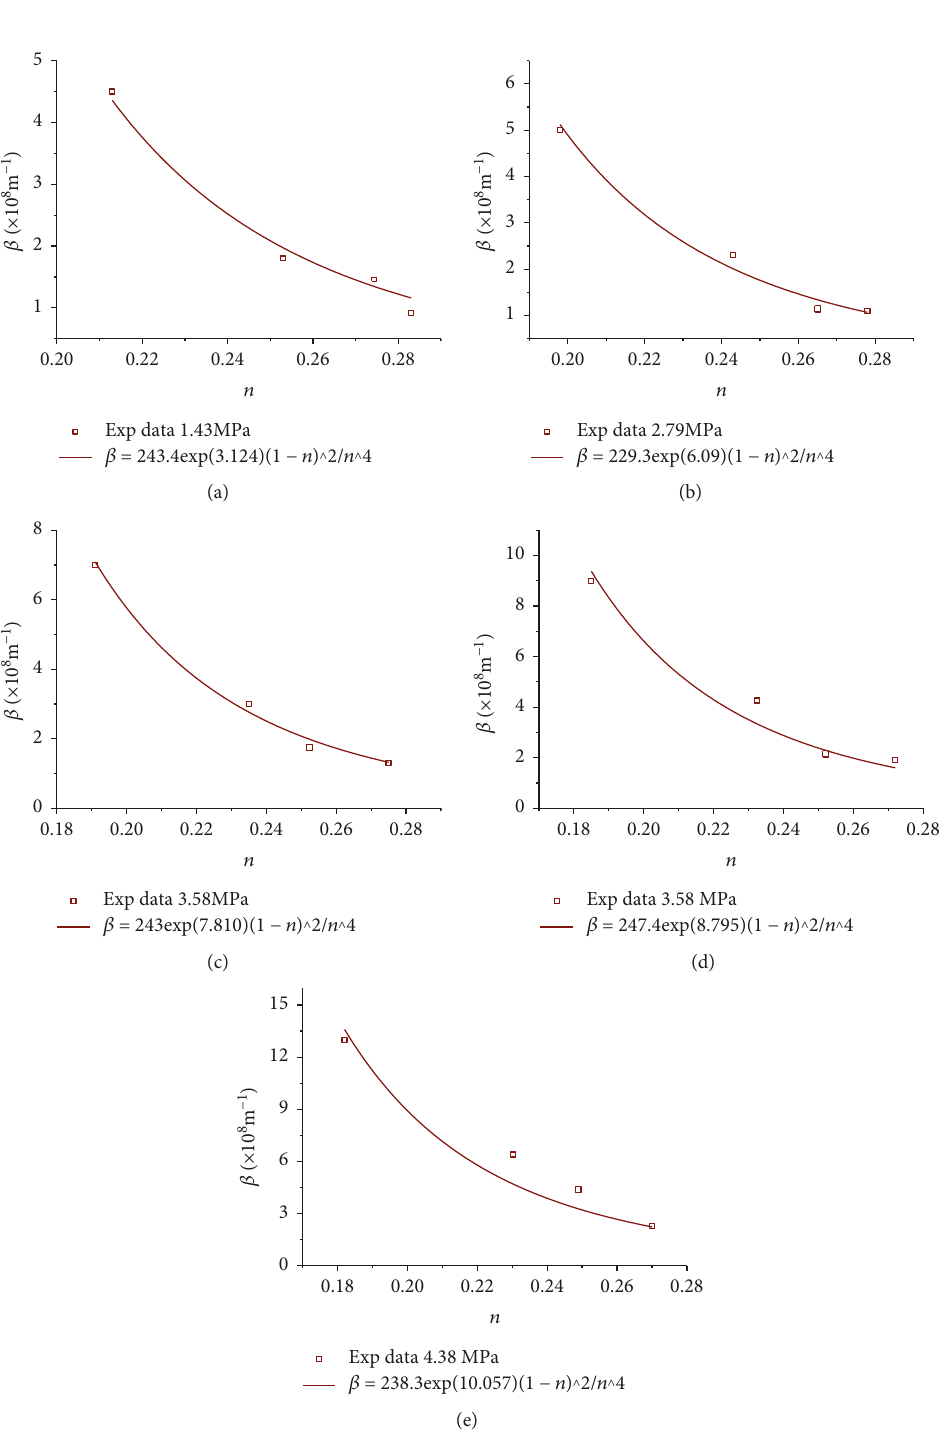
Figure 7: Inertial resistance β characteristic with the in fl uence of initial porosity under di ff erent